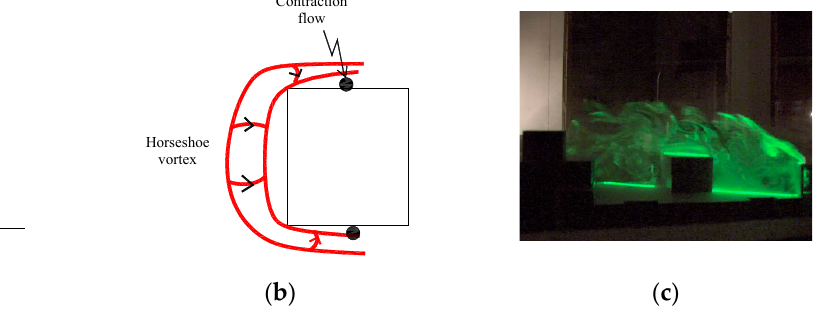
Figure 2. Typical flows around bluff bodies: ( a ) the common boundary layer separation with the production of vortices and turbulence; ( b ) the common horse-shaped vortices developed at the base of high buildings developing strong convergence/divergence of the flow producing strong vorticity gradients; ( c ) the flow complexity around multiple obstacles very closed to each other as seen by a wind tunnel experiment.